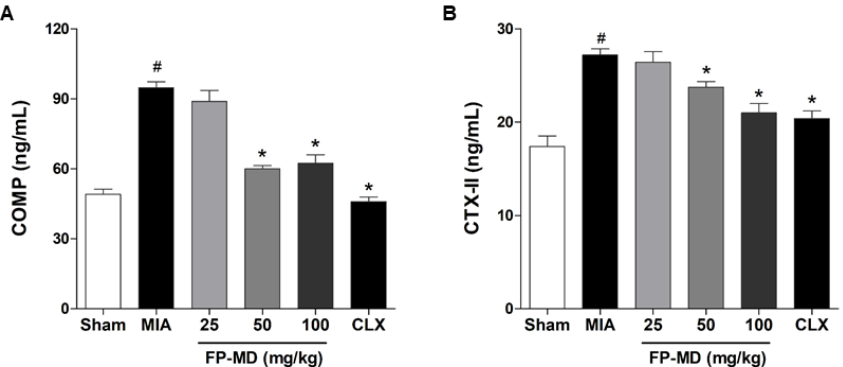
Figure 4. Effects of oral administration of FlexPro MD ® (FP-MD) on the production of cartilage oligomeric matrix protein (COMP) and C-telopeptide of type II collagen (CTX-II) in monosodium iodoacetate